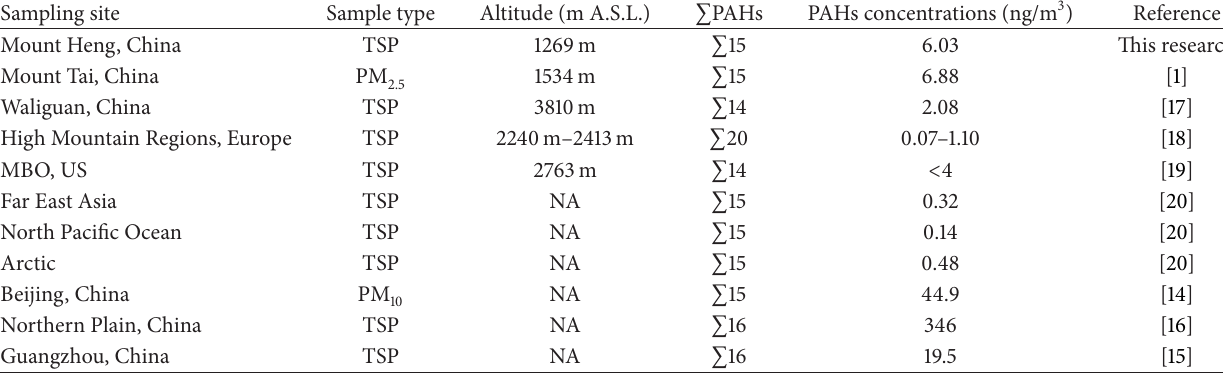
Table 3: Comparison of particulate-bound PAH levels between Mount Heng and other studies.